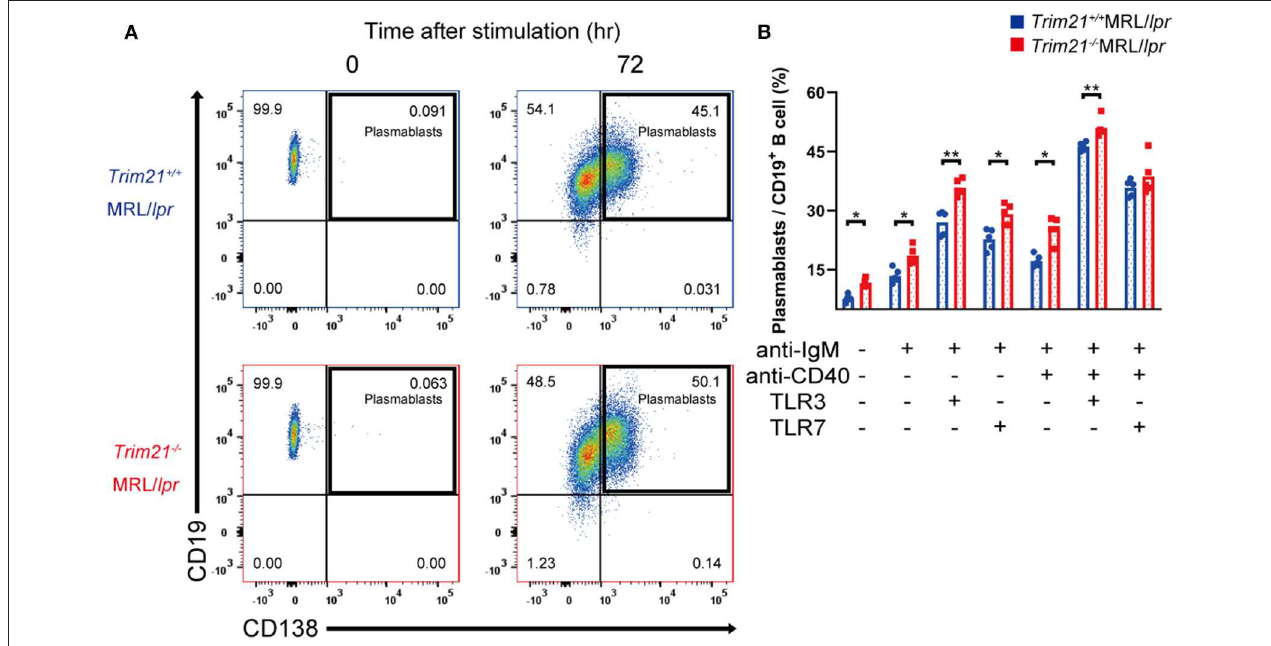
FIGURE 6 | TRIM21 deficiency promotes aberrant B cell differentiation in MRL/ lpr mice. (A) Flow cytometric analysis shows an increased rate of CD19 + CD138 + plasmablasts at 72h after stimulation with anti-IgM Ab and TLR3 ligand in Trim21 − / − MRL/ lpr mice. (B) Percentage of plasmablasts at 72h after stimulation with anti-IgM Ab, anti-CD40 Ab, and/or TLR3/7 ligands ( n = 4 in each group). Statistically significant data (* p < 0.05 and ** p < 0.01) by Student’s t -test. See also Supplemental Figure 1 .